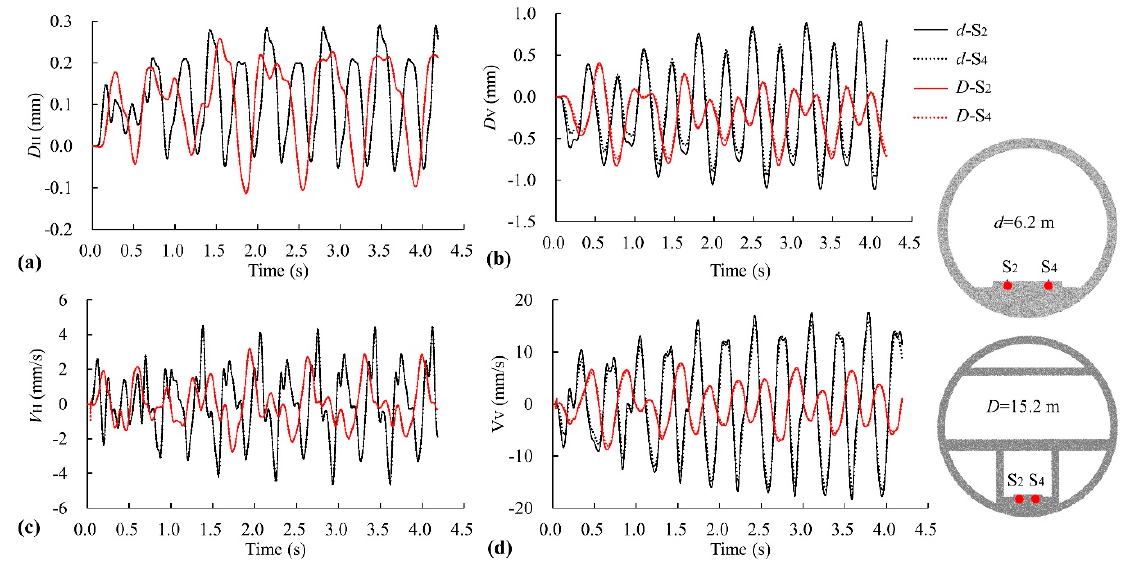
Figure 14. Displacement and velocity of sleepers between t2 and T2: ( a ) D H ; ( b ) D V ; ( c ) V H ; and ( d ) V V.